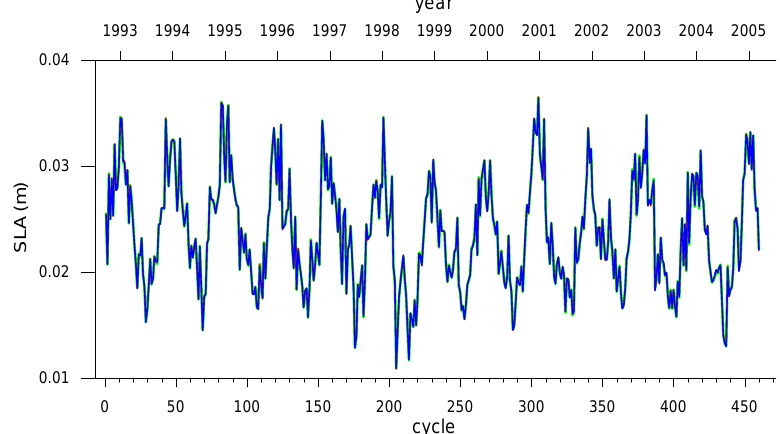
Figure 7b. SLA differences DataSet1-DataSet5 (non-IB-corrected versus IB Variable Reference Pressure). blue - Tropical; red : Sub-Tropical; green: Sub-Arctic.